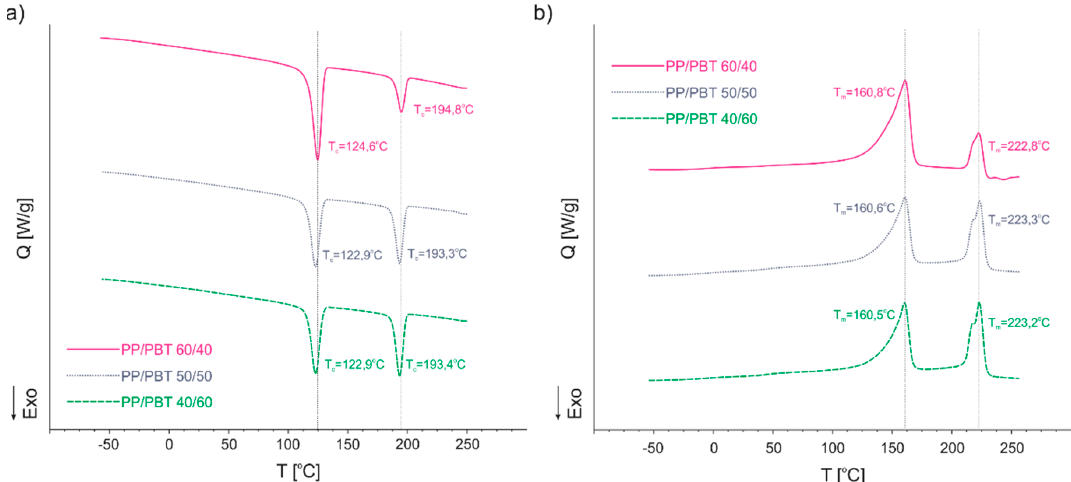
Figure 10. Differential scanning calorimetry (DSC) thermograms of uncompatibilized PP/PBT blends. ( a ) Comparison of crystallization behavior; ( b ) comparison of melting temperatures.